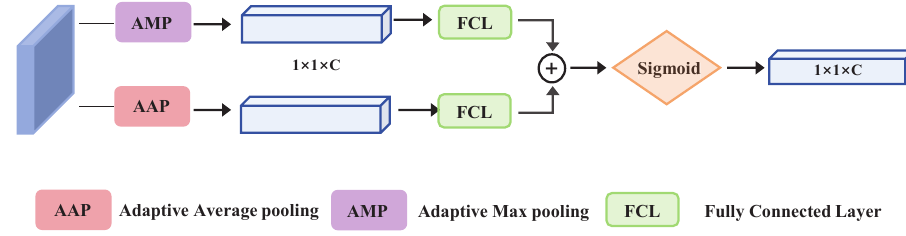
Figure 5. Structure of the attention-guided module